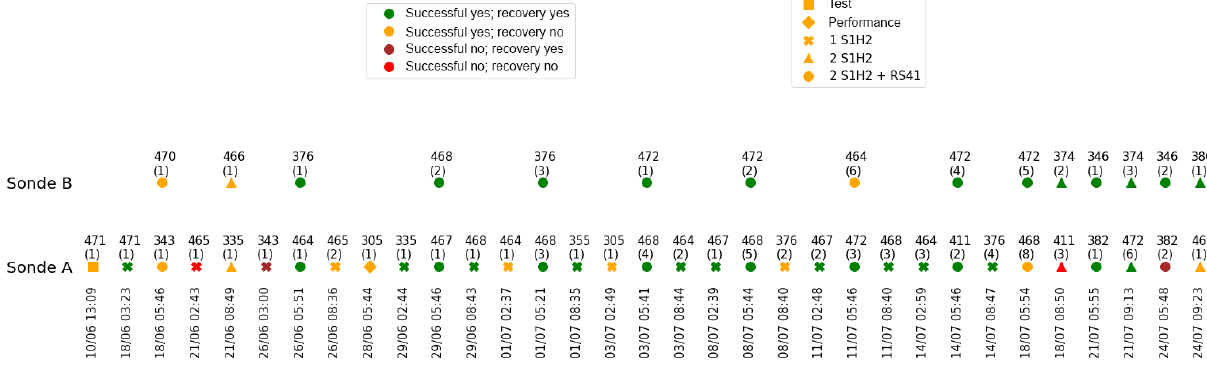
Figure 8. Timeline listing sounding time in UTC, the shapes indicate the corresponding number of radiosonde S1H2 that was launched (test denotes the test sonde, performance denotes the S1H2 launched taped to an RS41-SG, + RS41 denotes simultaneous launch with the Kumasi Agromet supersite); the sonde ID, with the number of times the sonde has been used in brackets, is indicated above the shape; and the colours indicate the flight result and the recovery result.